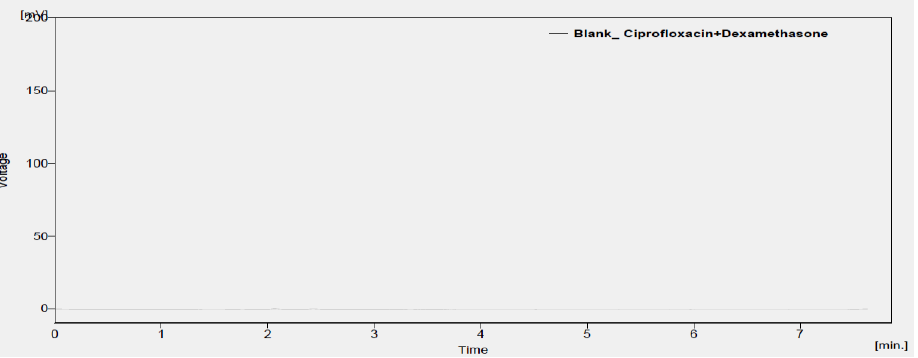
Figure 1: Chromatogram for blank.